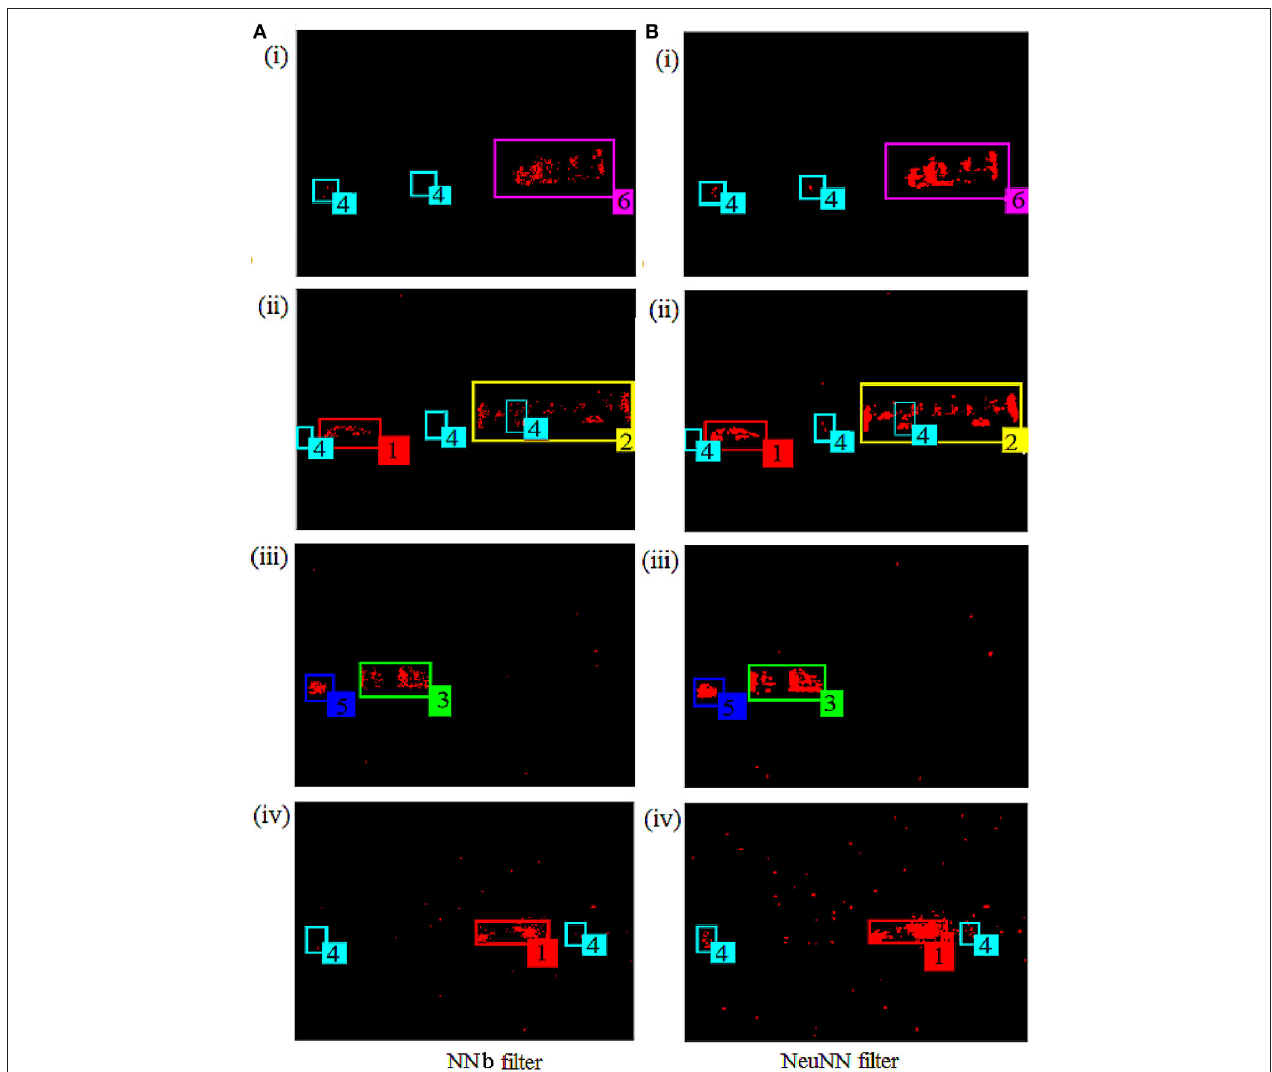
FIGURE 7 | Comparison of NNb filter on software (on the left) with the NeuNN filter on TrueNorth (on the right) using the same time instances and same files mentioned in Figure 1B